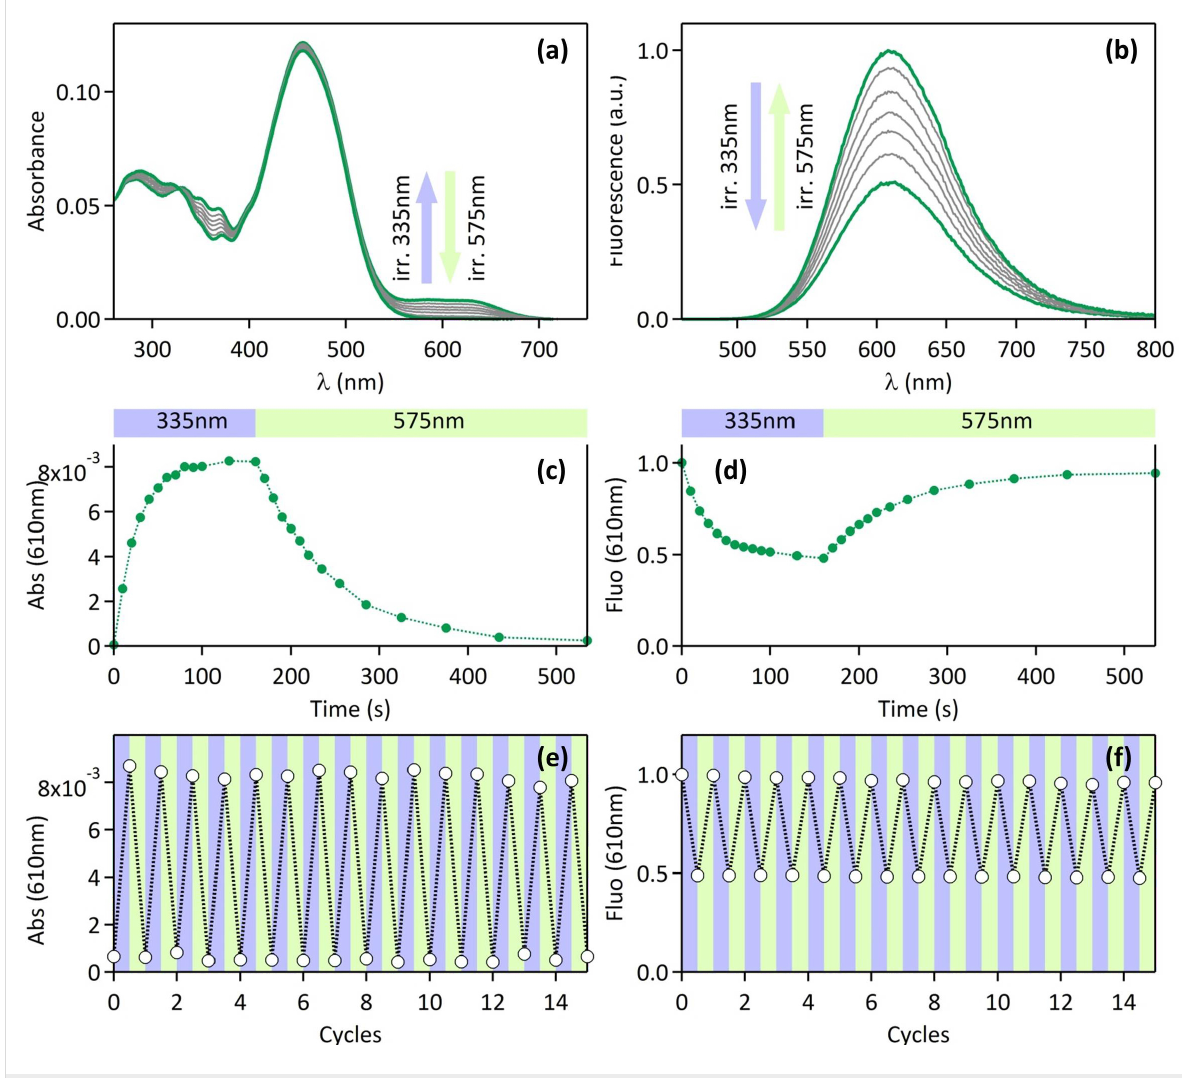
component at τ 2 = 0.35 ns, and a minor time-constant at τ 3 = 0.04 ns. The latter one has been neglected in the following discussion, since it is very close to the time-resolution of our instrument, and associated with a very low fraction of intensity (0.02). The two other time-constants are attributed to the E -isomer ( τ 1 ) and the Z -isomer ( τ 2 ) of the fluorophores, which is consistent with our previous studies [4]. The fluorescence decays of 2 -OF and 2 after irradiation at 335 nm are plotted in Figure 6a, and the result of a global three-exponential fitting procedure is displayed on Table 1. The three time-constants obtained by this method are in the same range as the ones deter- mined for 6 : τ 1 = 1.26 ns, τ 2 = 0.47 ns, τ 3 = 0.05 ns,